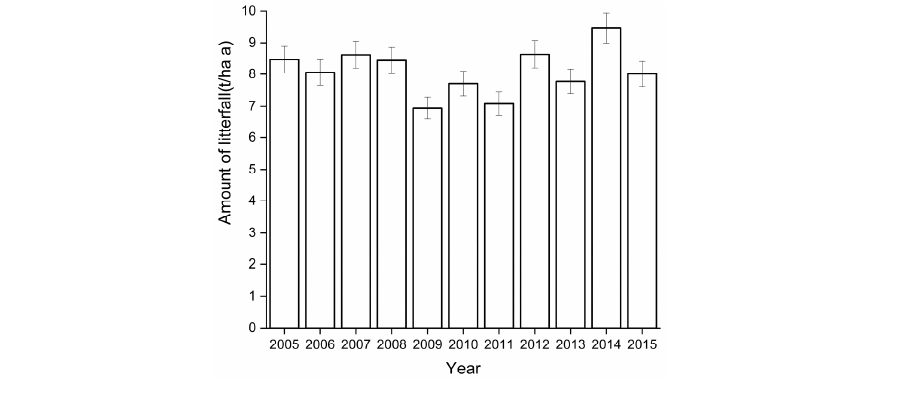
Figure 1. Interannual dynamics of litterfall from 2005 to 2015. Table 1. Annual total litterfall productions and components .